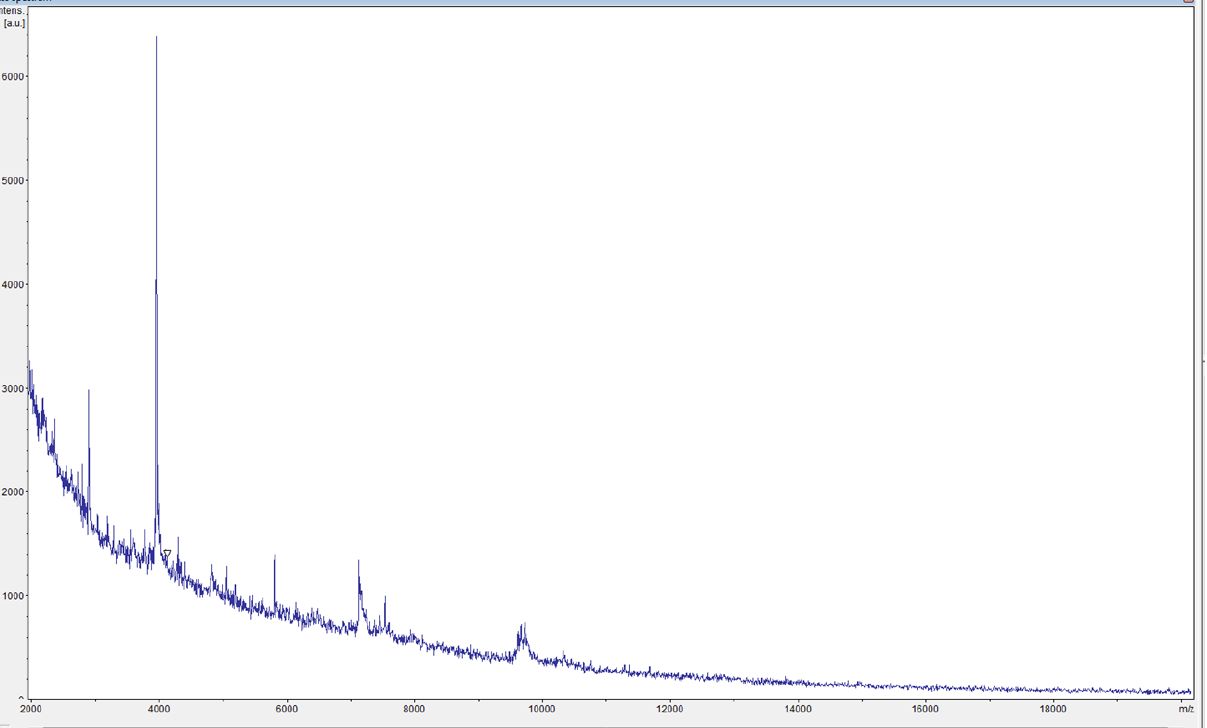
Figure 3. P. l. larvae (strain ATCC 9545, ERIC I): a spectrum of this bacterium obtained with a MALDI-TOF MS